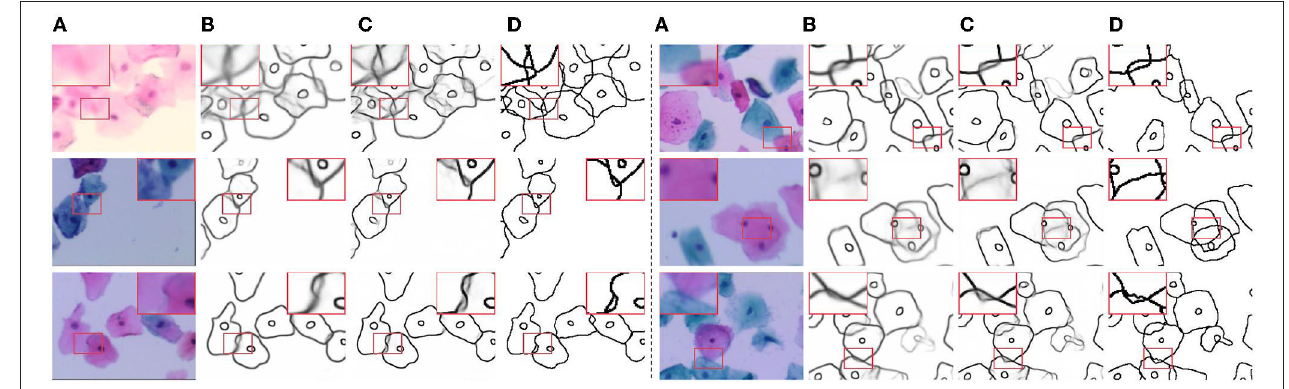
FIGURE 9 | Visual comparison results of training with different labels. (A) Input image; (B) UNet++ (Zhou et al., 2019)/BCELoss + Original label; (C) UNet++ (Zhou et al., 2019)/BCELoss + Corrected label; (D) Corrected labels. Compared with the original label, the corrected label can improve the accuracy of overlapping edge detection.